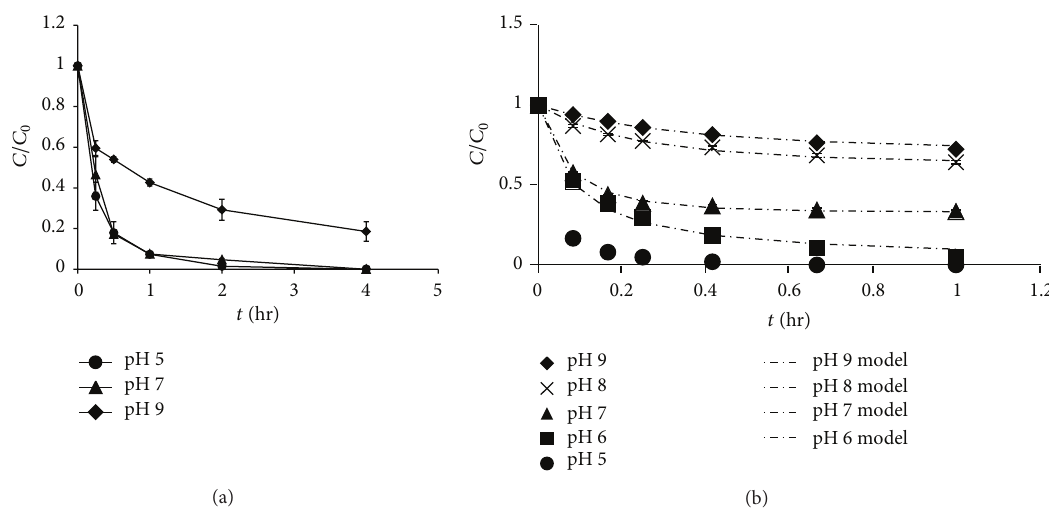
Figure 2: Effect of solution pH on the oxidation of controlled substances by MnO 2 : (a) morphine (with 100 𝜇 g/L MnO 2 ) and (b) codeine (with 8mg/L MnO 2 ) (morphine and codeine = 100 𝜇 g/L, pH = 7, and ionic strength = 10mM) (the second-order kinetic model developed by Zhang et al. [11] was fitted to describe the codeine